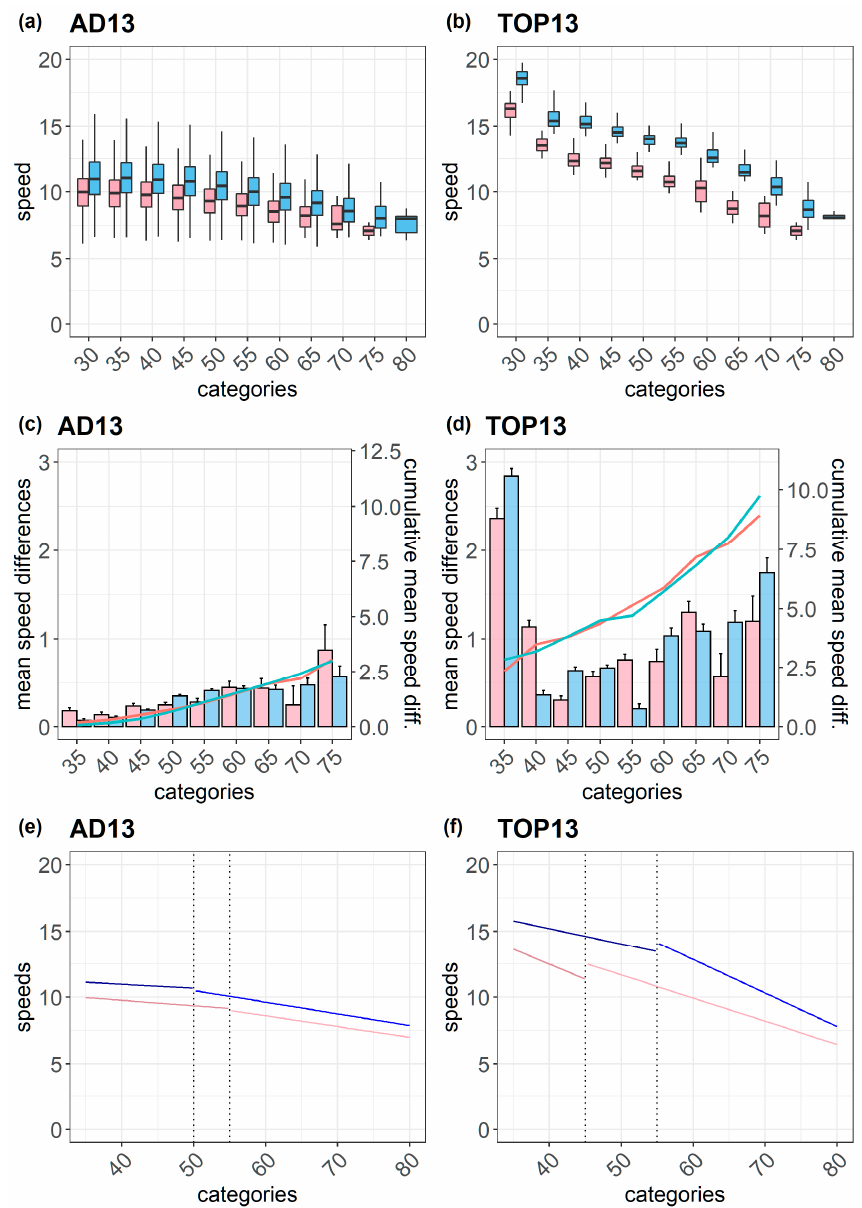
Figure 3. General analysis of speeds among participants in all 13 VM editions: Mean speed distributions grouping the 13 editions of the VM by age category among ( a ) AD13 and ( b ) TOP13. Differential (histograms) and cumulative (lines) differences in mean speeds by category among ( c ) AD13 and ( d ) TOP13. Piecewise regression lines for median speeds of ( e ) AD13 and ( f ) TOP13 athletes; the category 30 (24–34 years) in ( e ) and ( f ) has been removed. Males are represented by blue histograms or dotted lines, and females by pink histograms or continuous lines.